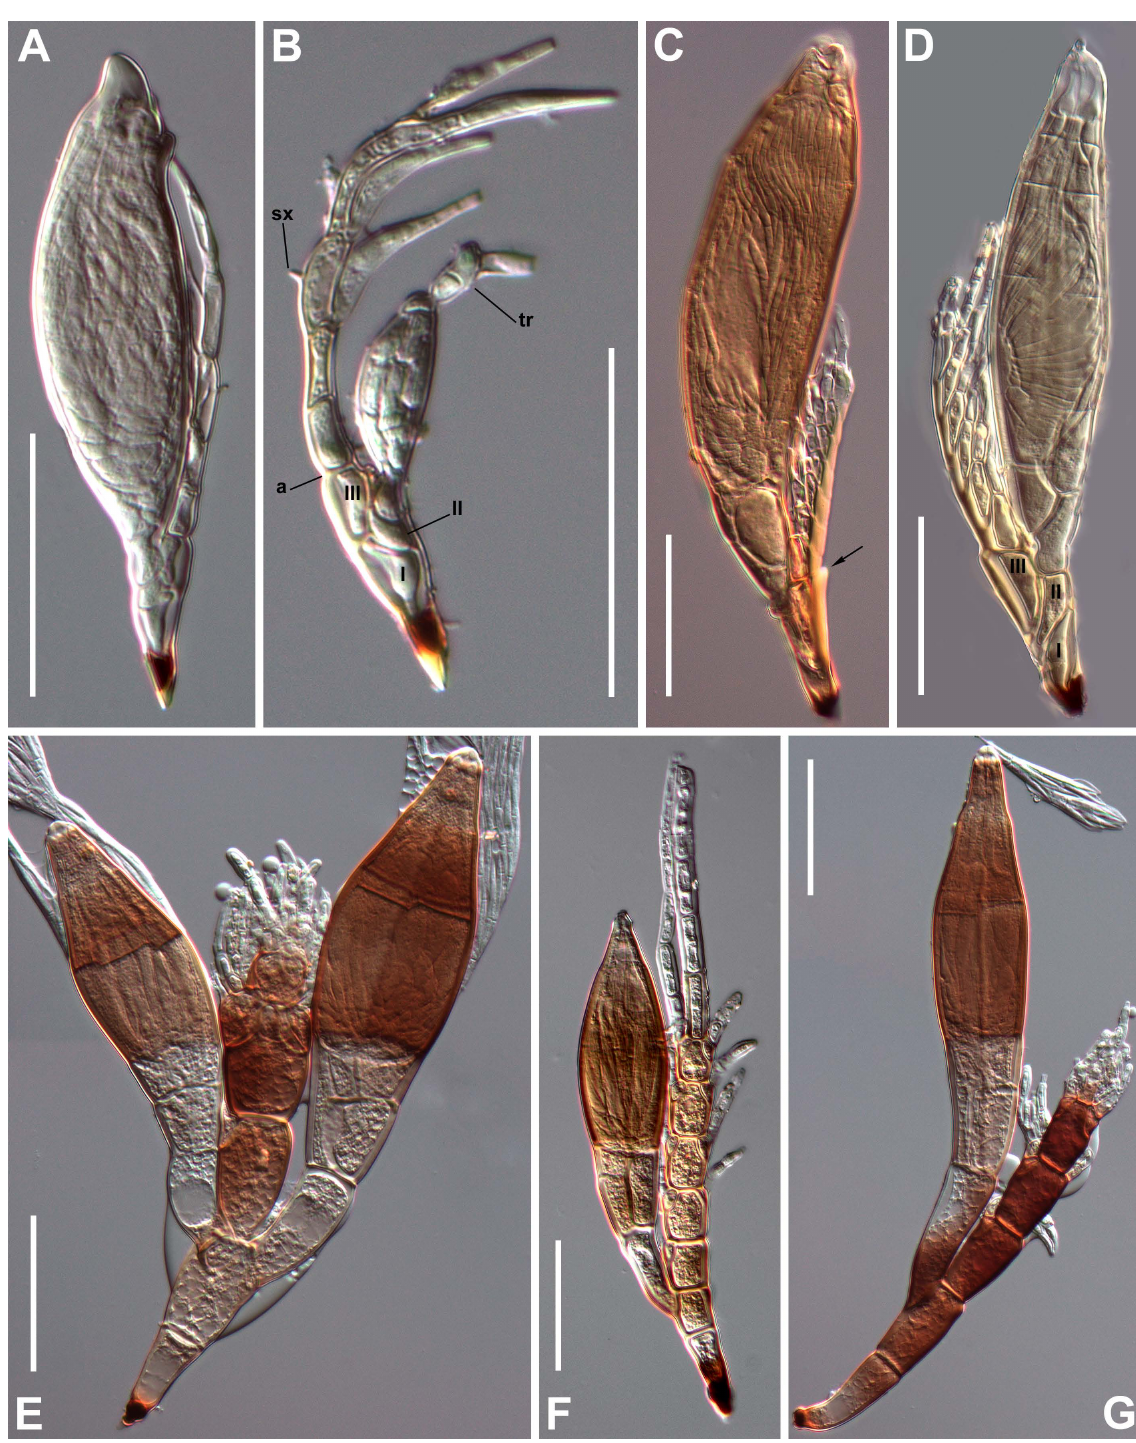
Fig. 55. A – B . Rossiomyces falcatus (T.Majewski) R.K.Benj. A . Mature thallus. B . Immature thallus showing labelled cells I, II, III, primary septum (a), trichogyne (tr), and spinous process from the original spore apex (sx). – C – D . Sphaleromyces lathrobii Thaxt. C . Mature thallus showing protrusion of cell III (arrow). D . Mature thallus from Spain showing labelled cells I, II and III. – E – G . Stichomyces conosomatis Thaxt. Mature thalli. Scale bars: 50 µm. Photographs from slides ZMUC C-F-122733 (A–B), ZMUC C-F-124186 (C), BCB-SS1543a (D), ZMUC C-F-122729 (E, G), ZMUC C-F-122630